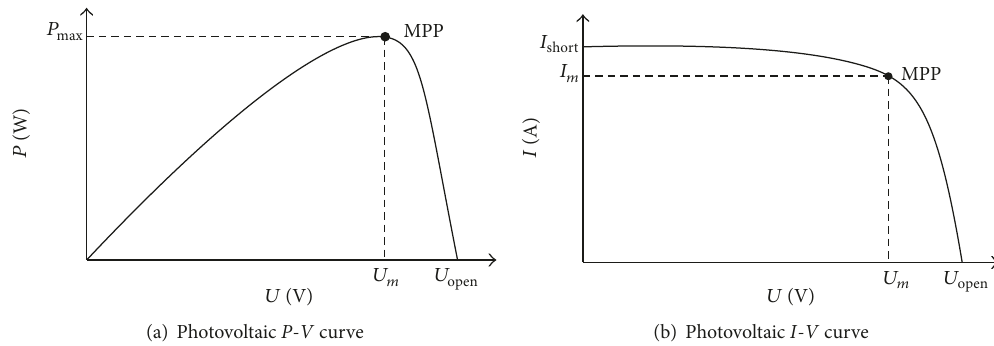
Figure 1: Output curve of photovoltaic solar